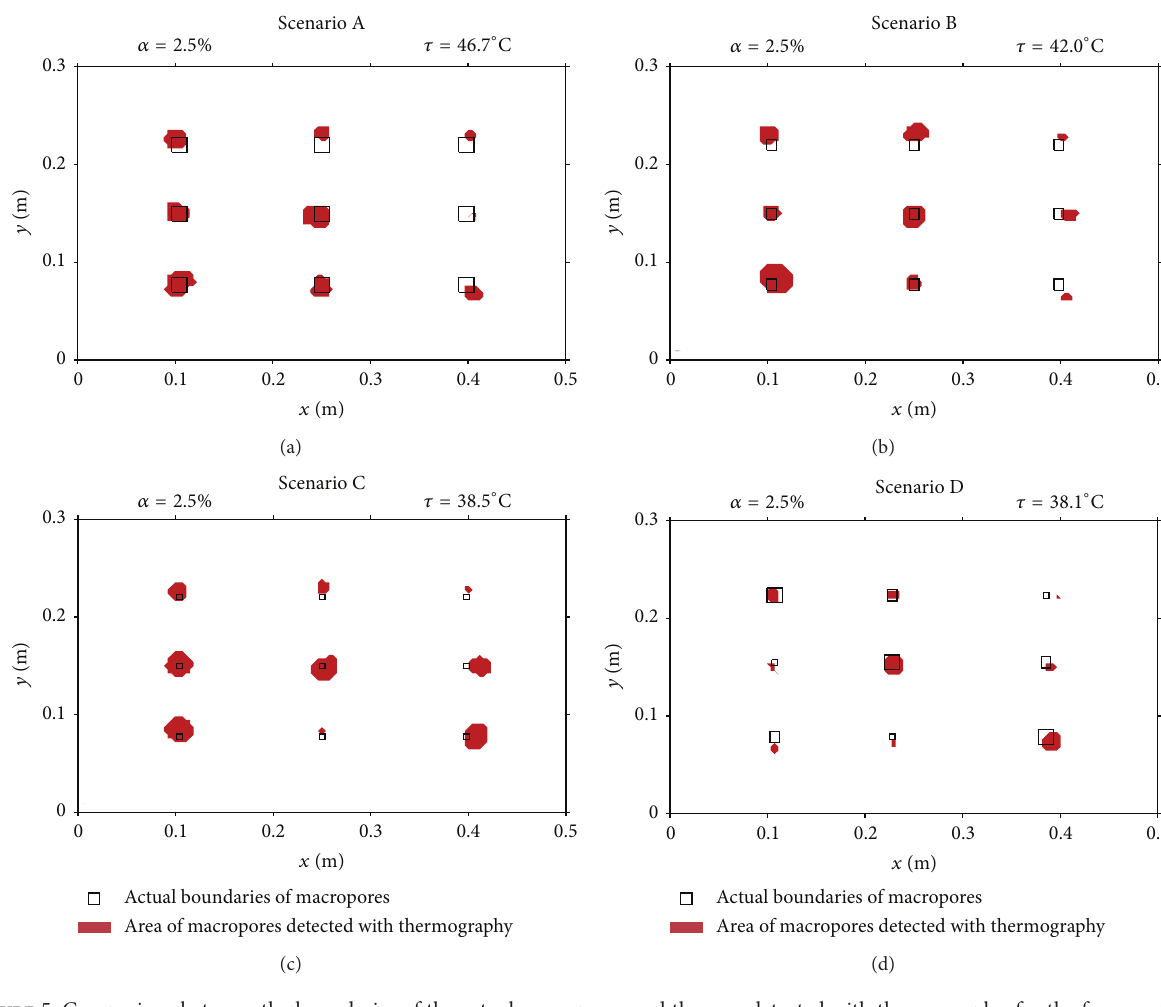
Figure 5: Comparison between the boundaries of the actual macropores and the area detected with thermography, for the four scenarios. Across the area scanned by the thermographic camera, the macropores are located using ( 𝑥,𝑦 ) coordinates. The 𝑥 -axis represents the downslope distance along the length of the flume (0.5 m) and the 𝑦 -axis represents the distance across the width of the flume (0.3 m). See also Figures 2 and